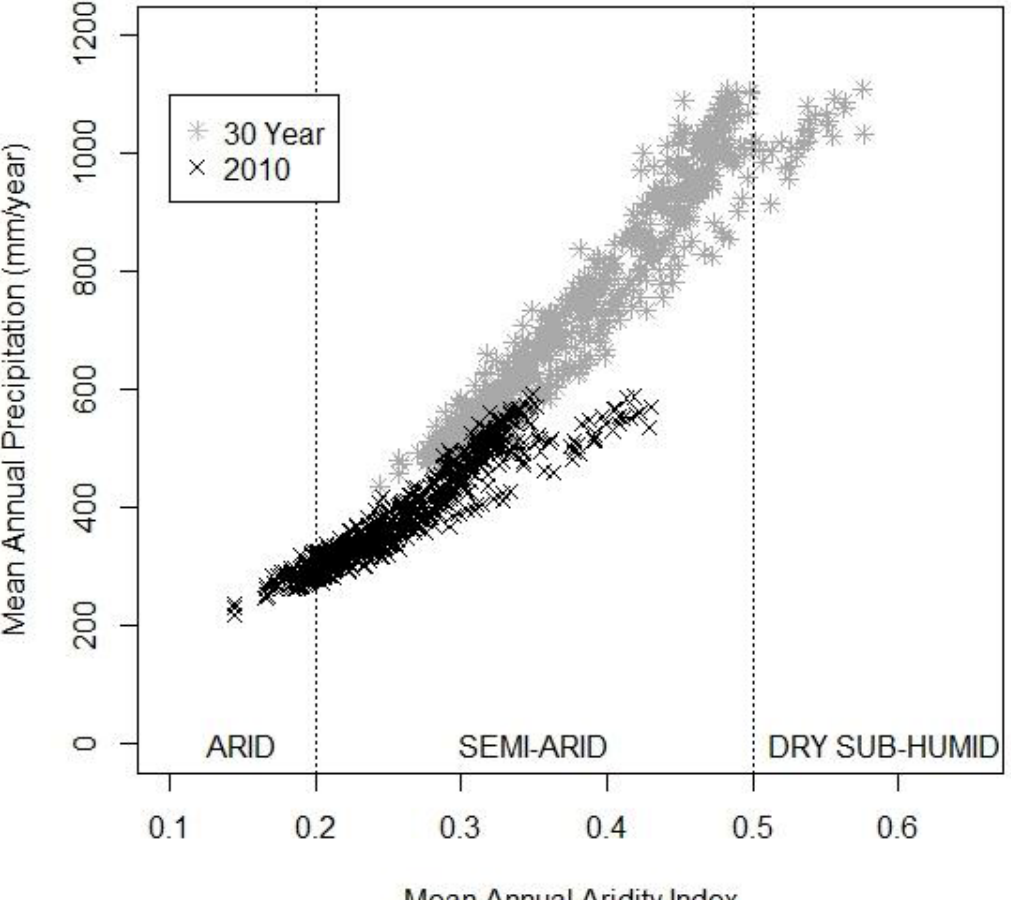
Figure 6. Spatially aggregated comparison of the NJF's Mean Annual Aridity Index versus Mean Annual Precipitation (mm/year). Averages over the period 1981–2009 are shown in grey and the 2010–2011 in